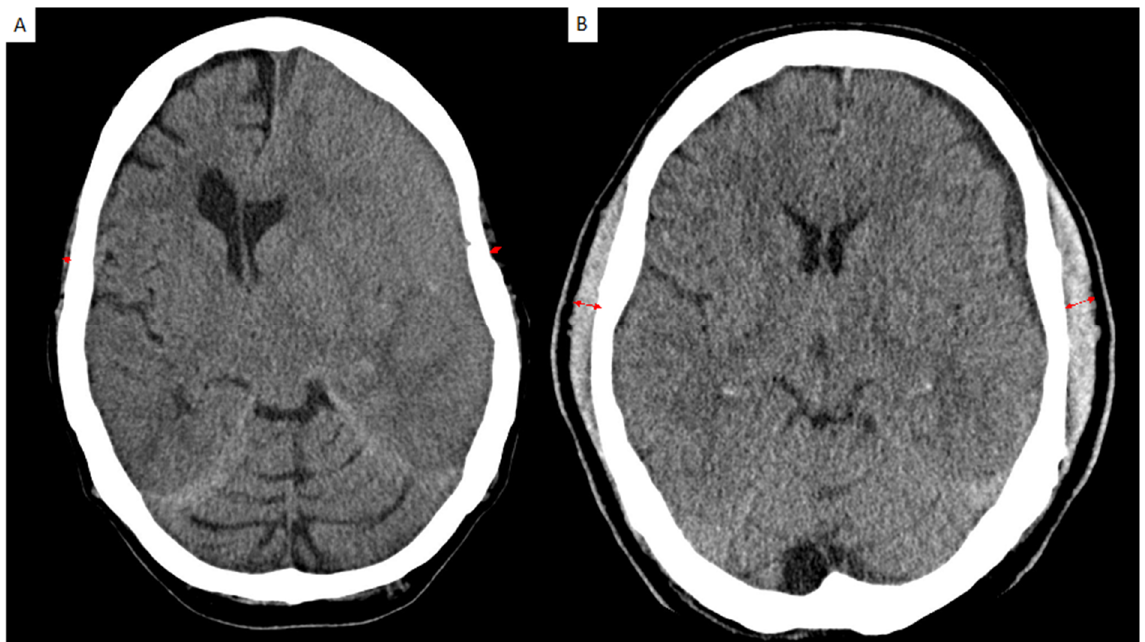
Figure 1. Representative case for the assessment of temporalis muscle thickness (TMT) on cranial CT scan shown in red arrows. ( A ) TMT measurement on axial CT scan image of a patient with low-volume TMT (bilateral mean TMT = 2.3 mm) and ( B ) a patient with a high-volume TMT on axial CT scan analysis (bilateral mean TMT = 8.1 mm).